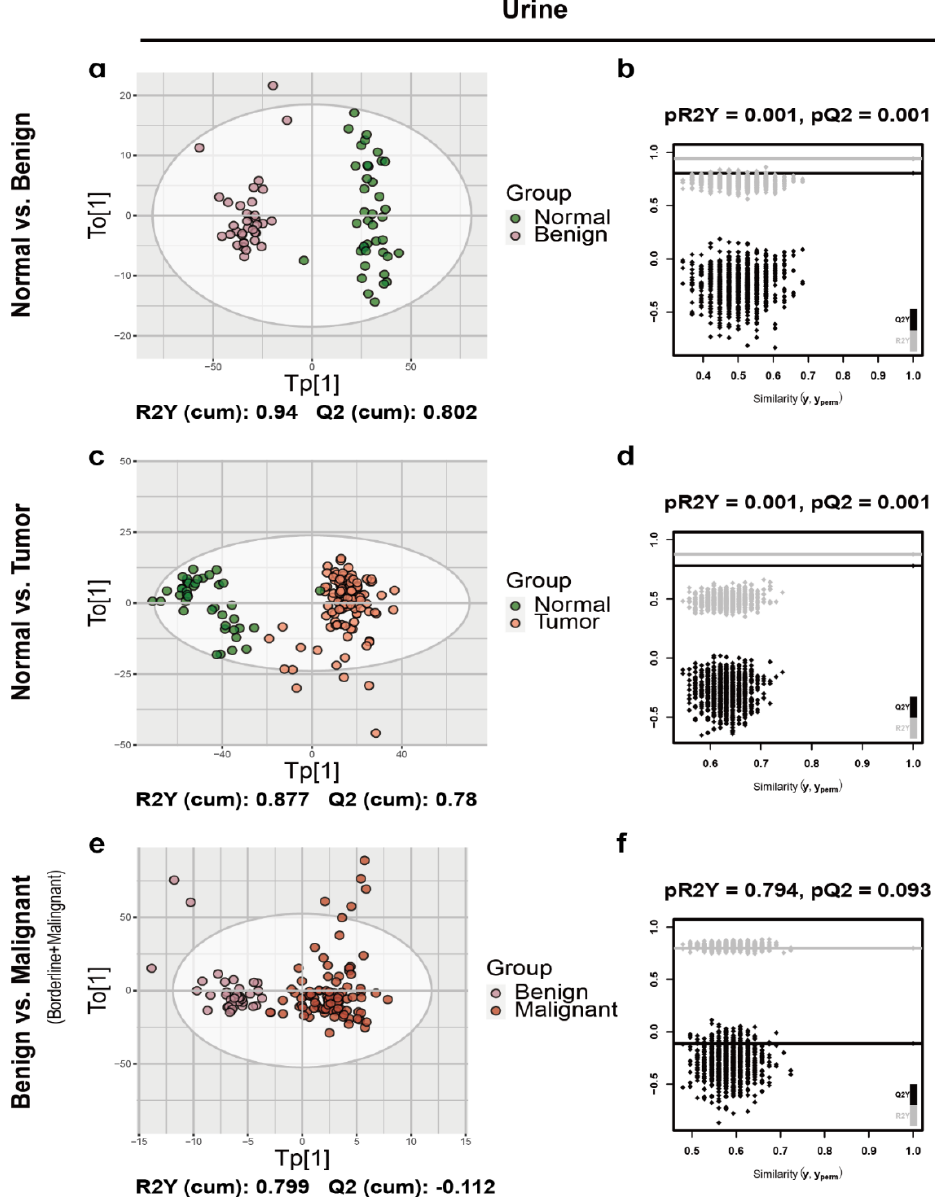
Figure 1. The orthogonal partial least-squared discriminant analysis (OPLS-DA) score plot and the permutation test results of urine samples. The OPLS-DA score plot between ( a ) normal and benign, ( c ) normal and ovarian tumor and ( e ) benign and malignant (borderline + malignant) ovarian tumors in plasma samples and the corresponding permutation test results ( b , d , f ).